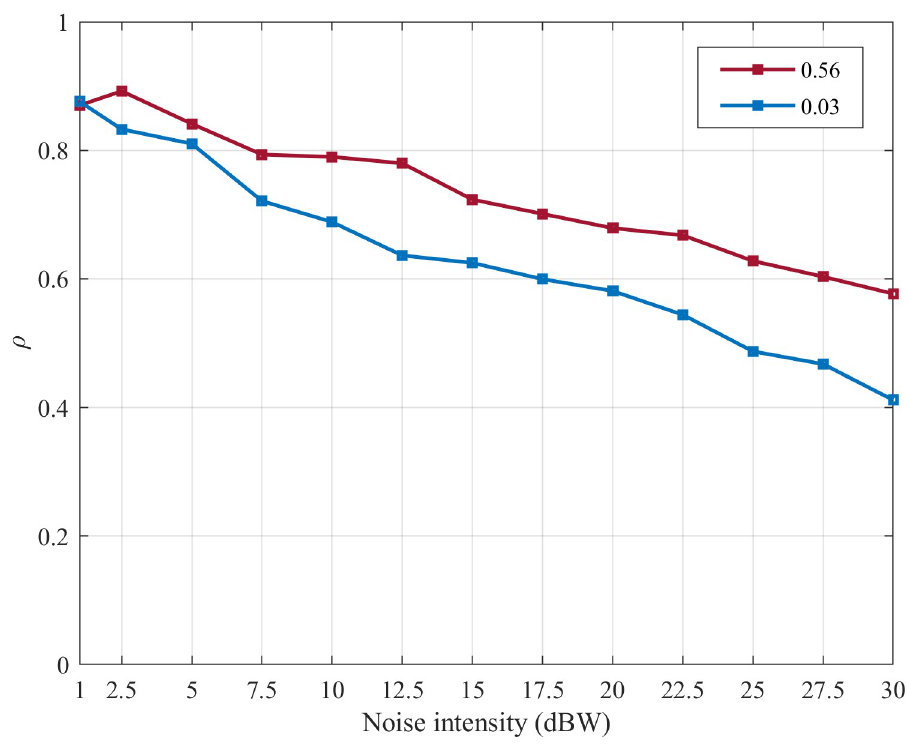
Fig 13. The change of the ρ of a SFSNN with the high ACC and a SFSNN with the low ACC.